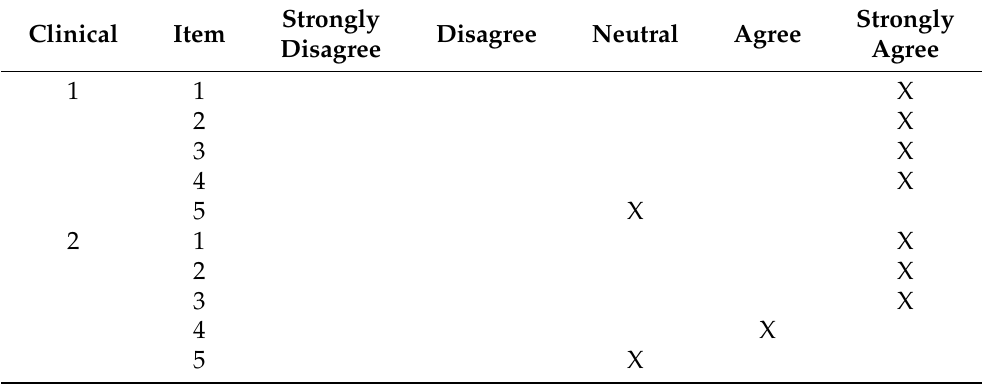
Table 4. Results of the clinician